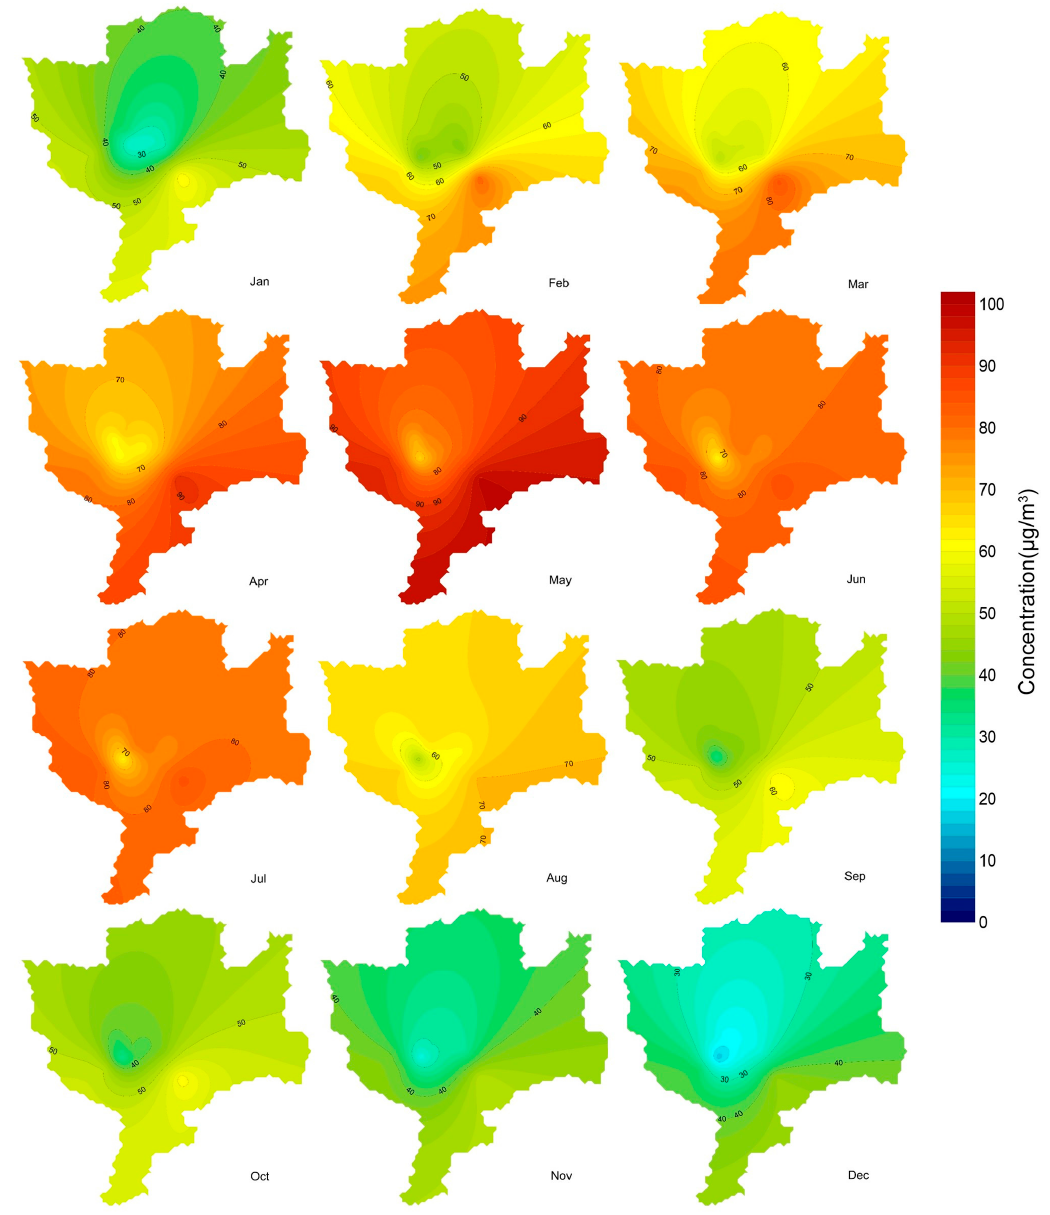
Figure 2. The spatial distribution of the monthly average O 3 concentrations for five years in Changchun during 2013–2017.